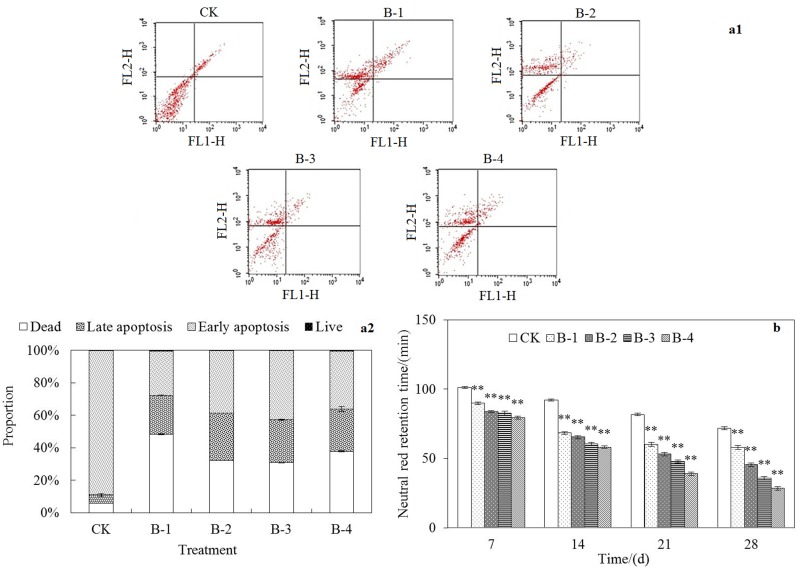
Cytotoxicity of DnBP determined by flow cytometry assays.(a) coelomocyte apoptosis (a1,a2) stained with Annexin V-FITC and PI (Upper left quadrant, necrotic cells; upper right quadrant, late/secondary apoptotic cells; bottom left quadrant, live cells; and bottom right quadrant, early/primary apoptotic cells) in the 28th day and (b) lysosomal membrane stability characterized by NRR time in extruded coelomocyte of treated E. fetida in the 7th, 14th, 21st and 28th day after exposure in spiked natural soil CK, B-1, B-2, B-3, and B-4 for 28 days (n = 4; error bars, SEM). Refer other annotates to Fig 1.